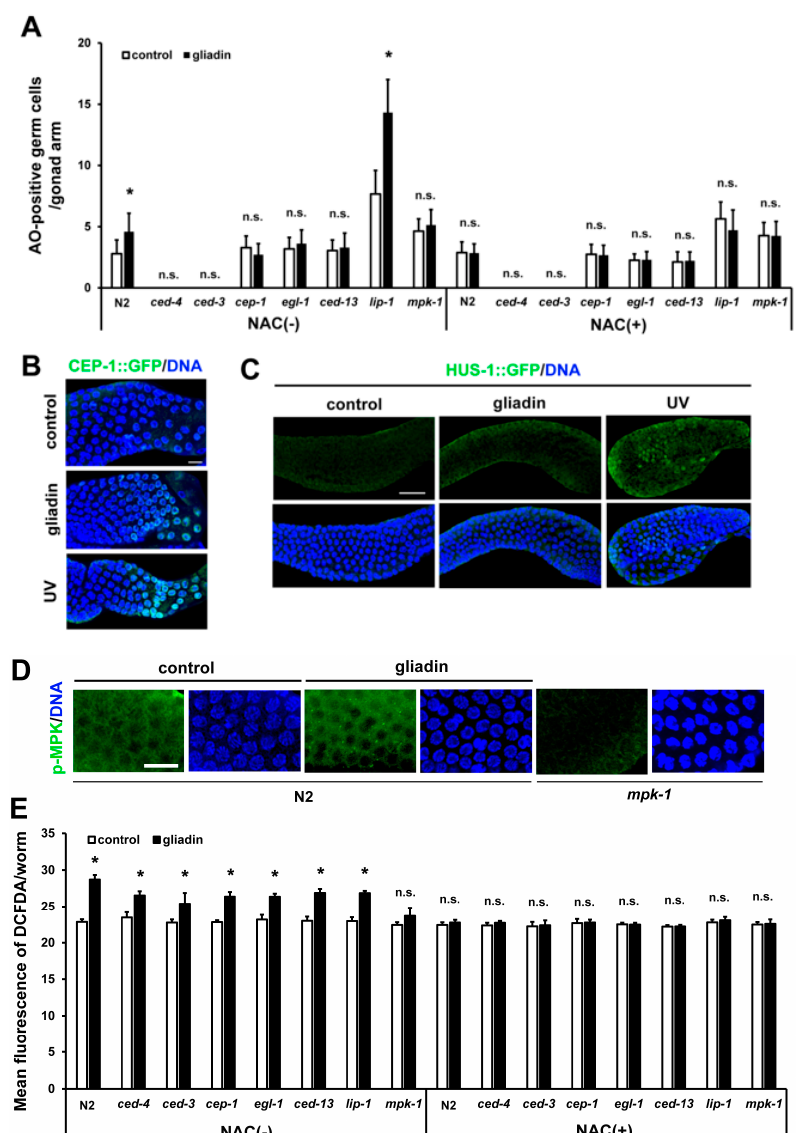
Figure 8. E ff ects of CEP-1 activity and mitogen-activated protein kinase (MAPK) signaling on gliadin-induced germ cell apoptosis (GIGA) in adult C. elegans worms. ( A ) Average numbers of acridine orange (AO)-positive germ cells per gonad arm in wild-type N2, ced-4 , ced-3, cep-1, egl-1, ced-13, lip-1 , and mpk-1 mutants ( n = 30–40 per group) after gliadin treatment for 24 h of treatment with N-acetyl-L-cysteine (NAC) ( + ) or without NAC (–) starting at the L4 larval stage. ( B ) CEP-1::GFP was observed by immunostaining in CEP-1::GFP transgenic animals ( n = 30 per group) fed with or without gliadin for 24 h starting in the L4 larval stage. UV-treatment condition was used as a positive control. Bar, 10 µ m. ( C ) HUS-1::GFP transgenic animals ( n = 30 per group) were synchronized at the L4 stage then treated with or without gliadin. HUS-1::GFP aggregates were observed after UV-treatment (positive control) by immunostaining using an anti-GFP antibody. Bar, 20 µ m. ( D ) Phospho-MPK was observed by immunostaining using an anti-Phospho-p44 / 42 MAPK antibody in wild-type N2 worms ( n = 32 per group) after gliadin treatment for 24 h starting during the L4 larval stage. Bar, 10 µ m. ( E ) Wild-type N2, ced-4 , ced-3, cep-1, egl-1, ced-13, lip-1 , and mpk-1 mutants ( n = 30–40 per group) after gliadin treatment for 24 h treated with NAC ( + ) or without NAC (–) starting at the L4 larval stage. Reactive oxygen species (ROS) production was measured by 2 (cid:48) ,7 (cid:48) -dichlorodihydrofluorescein diacetate (DCFDA) staining. The bar graph shows the pixel intensities from DCFDA fluorescence per worm. Error bars represent s.d.; n.s., not significant. * p < 0.05 (Student’s t